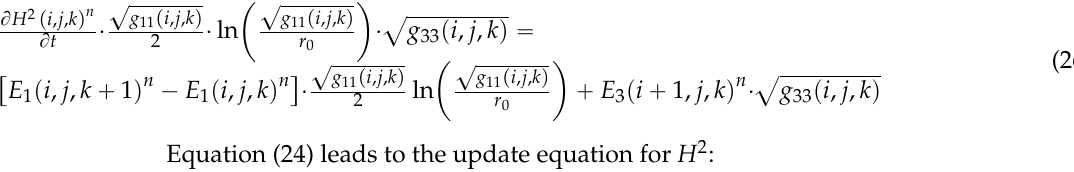
Equation (24) leads to the update equation for H 2